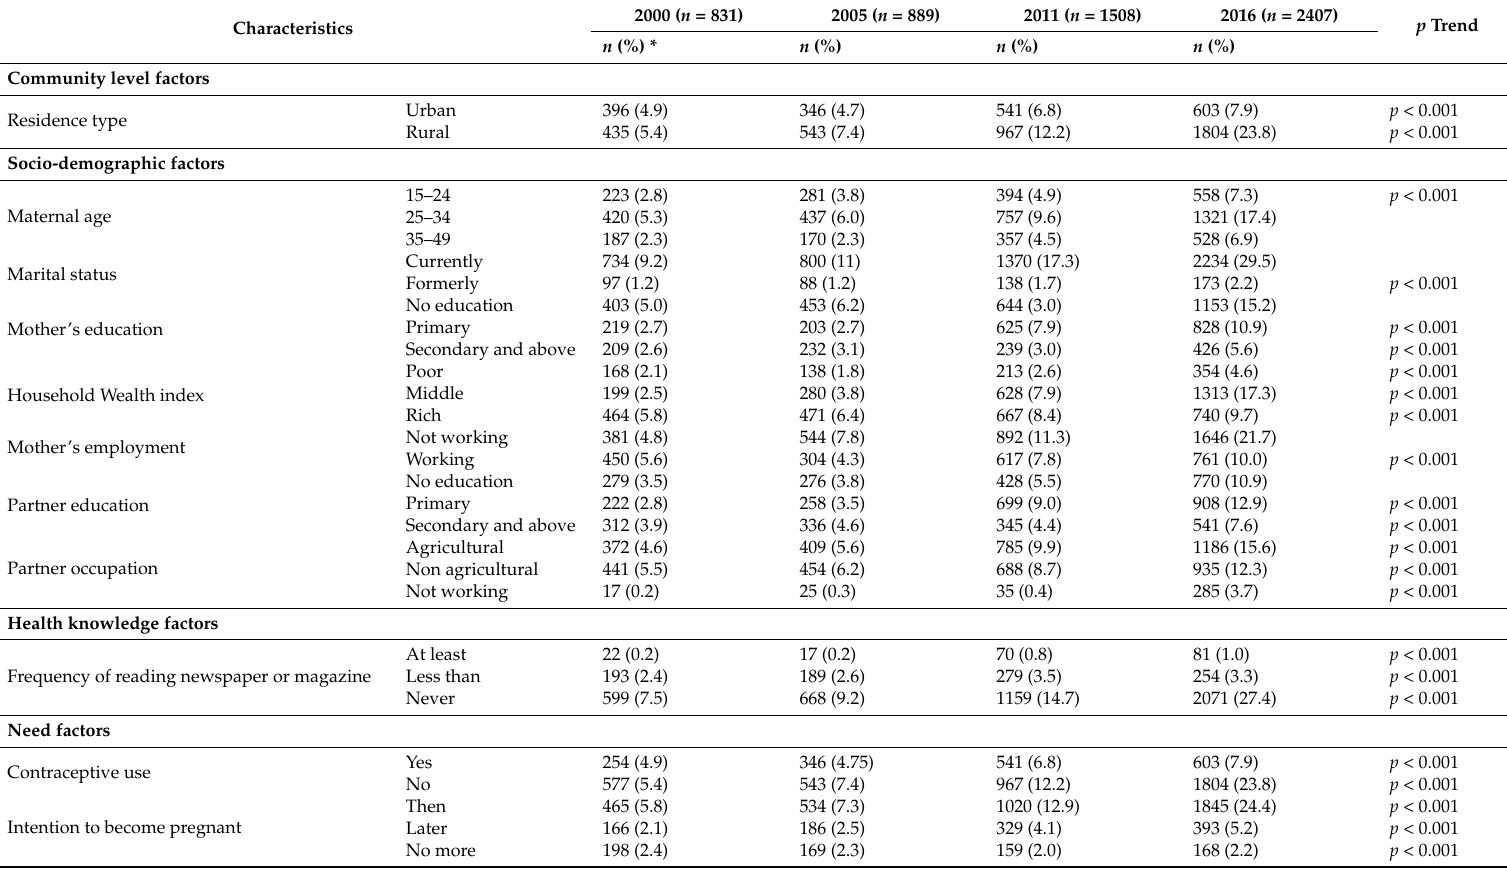
Table 2. Socio-demographic characteristics of the study participants who had four or more ANC visits.